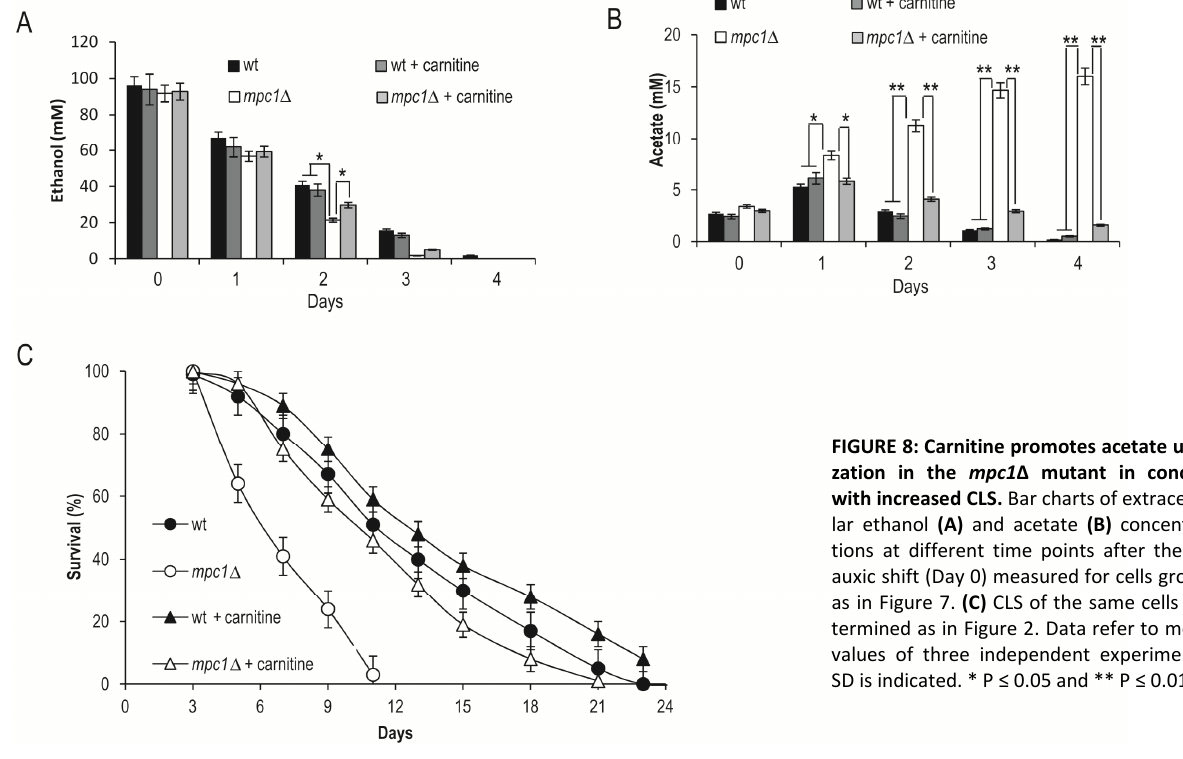
FIGURE 8: Carnitine promotes acetate utili- zation in the mpc1 ∆ mutant in concert with increased CLS. Bar charts of extracellu- lar ethanol (A) and acetate (B) concentra- tions at different time points after the di- auxic shift (Day 0) measured for cells grown as in Figure 7. (C) CLS of the same cells de- termined as in Figure 2. Data refer to mean values of three independent experiments. SD is indicated. * P ≤ 0.05 and ** P ≤